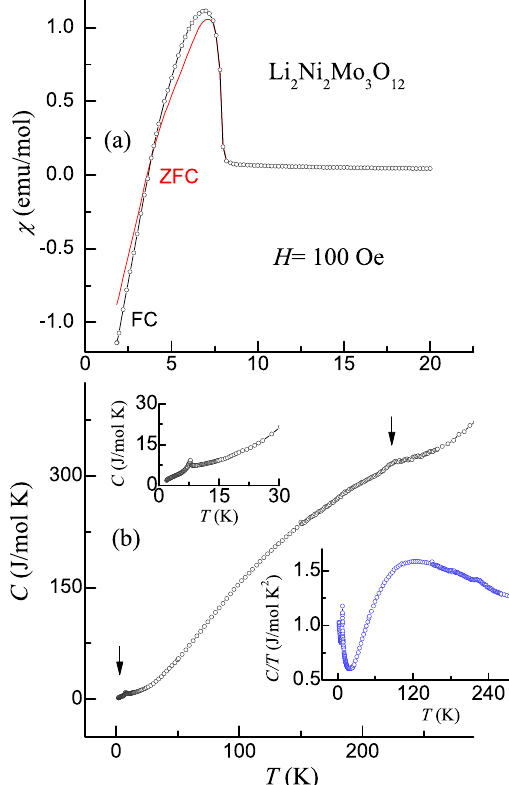
Figure 1. ( a ) Magnetic susceptibility obtained in 100 Oe for zero-field-cooled and field-cooled conditions of the specimen; ( b ) heat-capacity as a function of temperature for Li 2 Ni 2 Mo 3 O 12 in the absence of magnetic field; vertical arrows mark the features of interest. Top and bottom insets in ( b ) show the C and C/T plots to highlight the